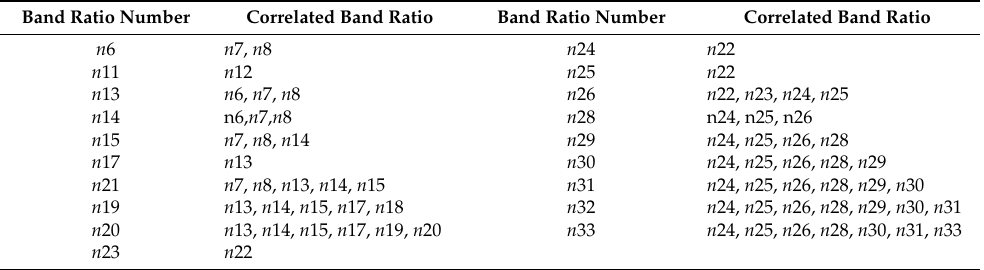
Table 5. Band ratios with the correlation coefficient higher than 0.90 for a selected subset of the study area.